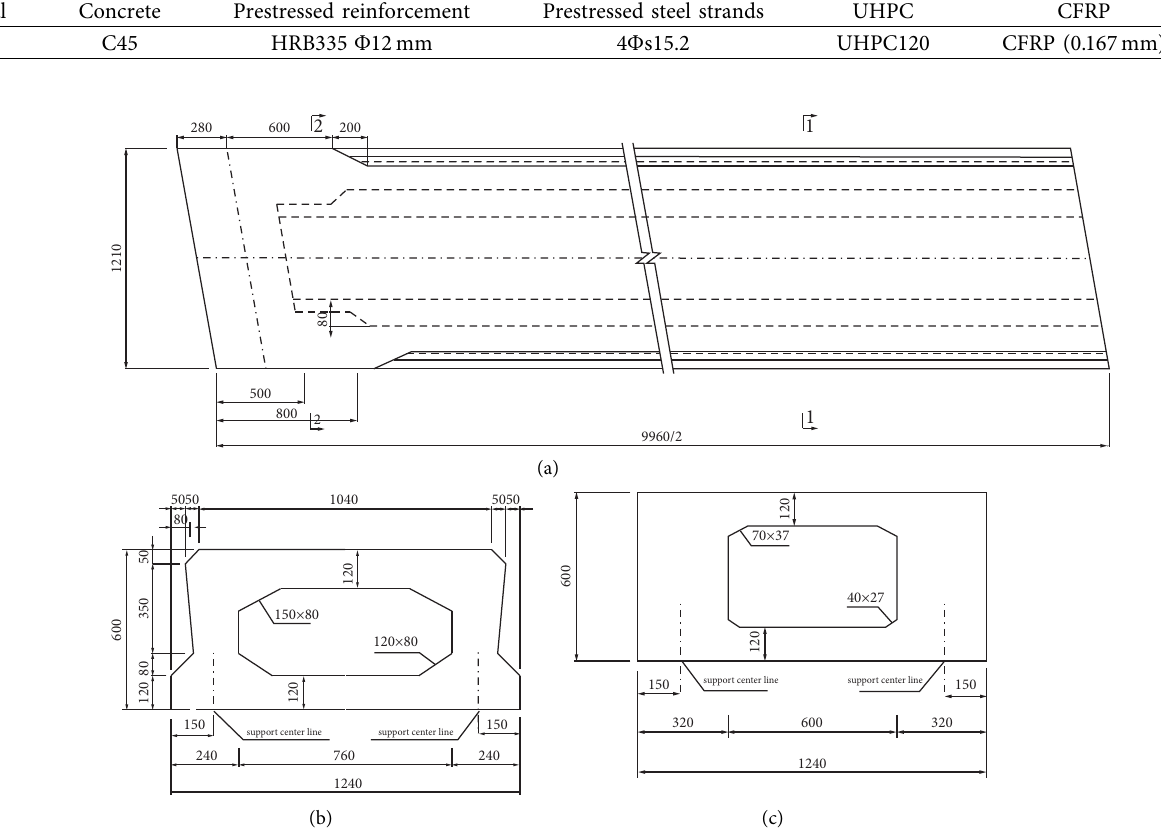
Figure 1: Structural drawing of the hollow slab beam. (a) Plan view. (b) Section 1-1. (c) Section 2-2.